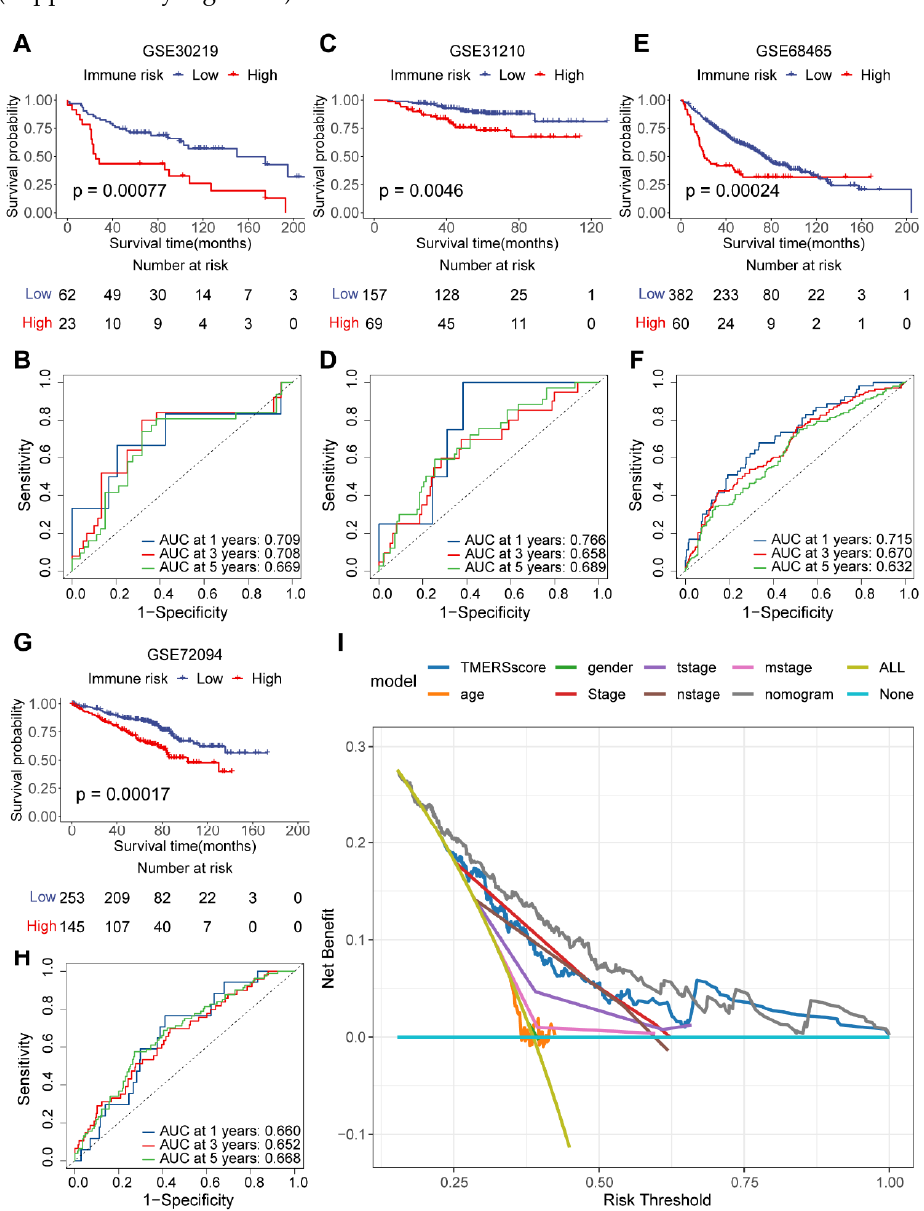
Figure 3. Validation of the performance of TMERSscore to predict survival. ( A , C , E , G ) are the Kaplan-Meier survival curves of TMERSscore in GSE30219, GSE31210, GSE68465, and GSE72094, respectively. ( B , D , F , H ) are the ROC curves of TMERSscore predicting the OS at 1, 3, 5 years in GSE30219, GSE31210, GSE68465, and GSE72094 dataset. ( I ) DCA curves compared the clinical ben- efit of TMERSscore with other risk factors at 3 years. The none plot represents the assumption that no patients have 3-year survival, while all plots represent the assumption that all patients have 3- year survival at a specific threshold probability. The x -axis represents the threshold probabilities, and the y -axis measures the net benefit. Overall, TMERSscore showed good predictive performance in the external validation set and in comparison with other prognostic models, with additional benefits for clinical